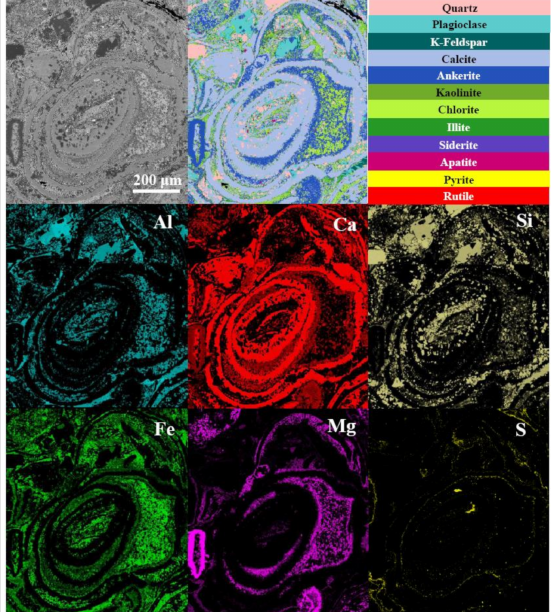
Figure 6. Scanning electron microscope photo and QemScan images of an ostracod filled with chlorite and ankerite. Color brightness in each map represents relative abundance of its corresponding element. Brighter color indicates higher element